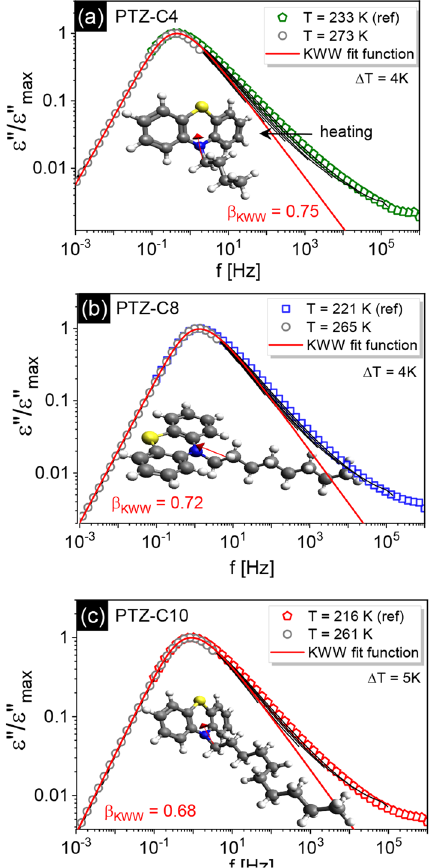
Figure 5. Master curves created by horizontal shifting of dielectric loss spectra on the reference spectrum (the spectra recorded for the highest and the lowest temperatures are shown as symbols, while those corresponding to the middle temperatures are depicted as black lines). The KWW fits to the dielectric loss spectra at reference temperatures are shown ( β KWW indicated). For PTZ-C10 total dielectric response was included in the analysis. The inserts show the chemical structure of the molecules along with the direction of the resultant dipole moment vector (red